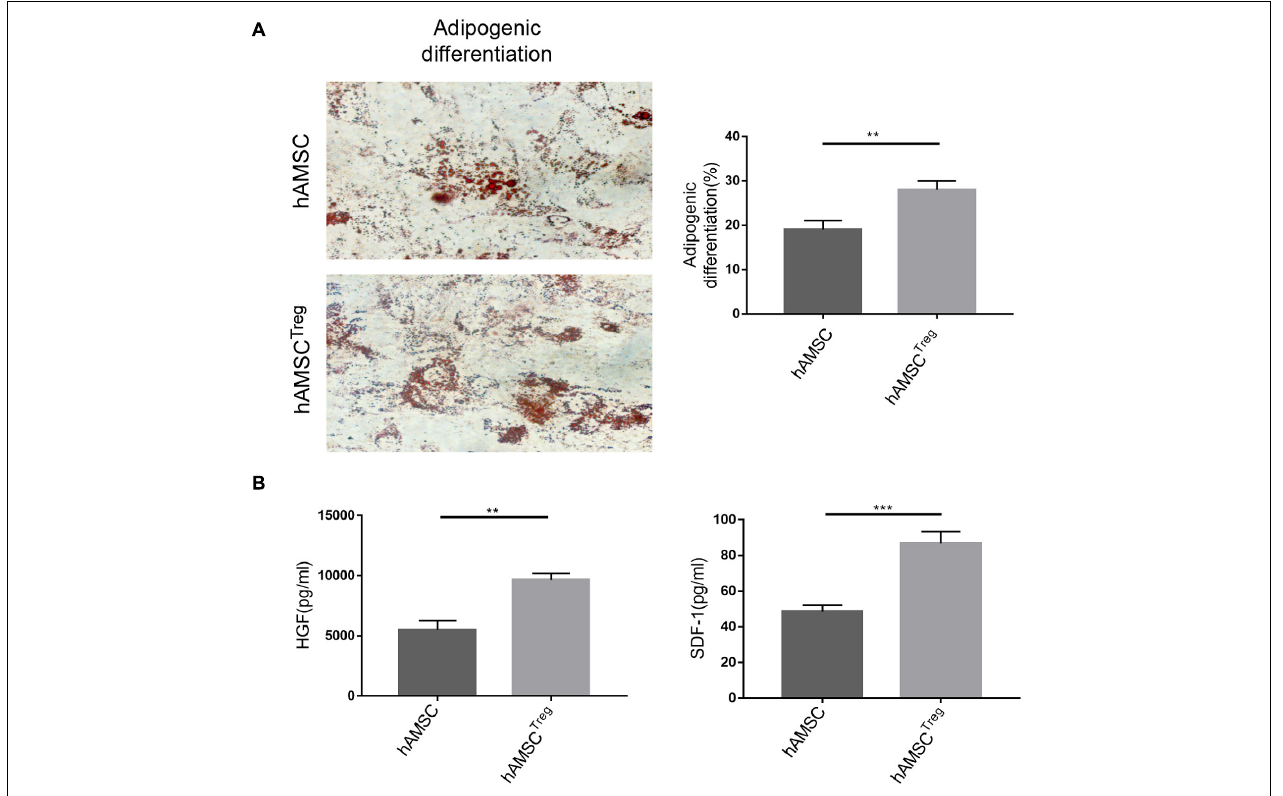
FIGURE 2 | hAMSC was treated with PBS and Treg in vitro . (A) Representative images of hAMSC’s adipogenic differentiation in two groups. (B) Level of HGF and SDF-1 in two groups. The result is representative of three independent experiments. Data were mean ± SD of three independent experiments. ** p < 0.01, *** p <